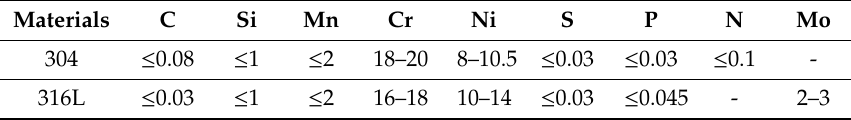
Table 1. Material characteristics of the base plate and welding